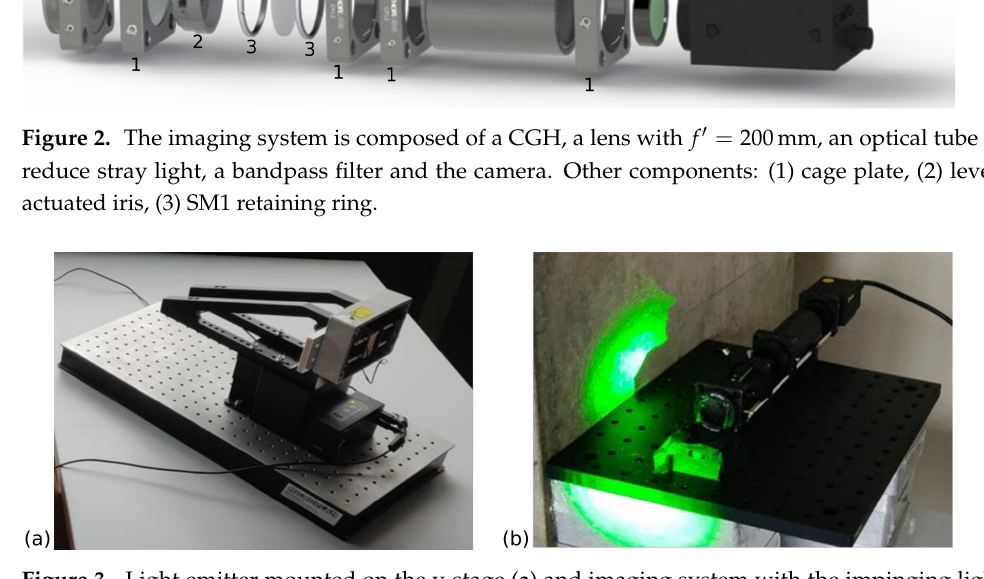
Figure 3. Light emitter mounted on the y-stage ( a ) and imaging system with the impinging light beam ( b